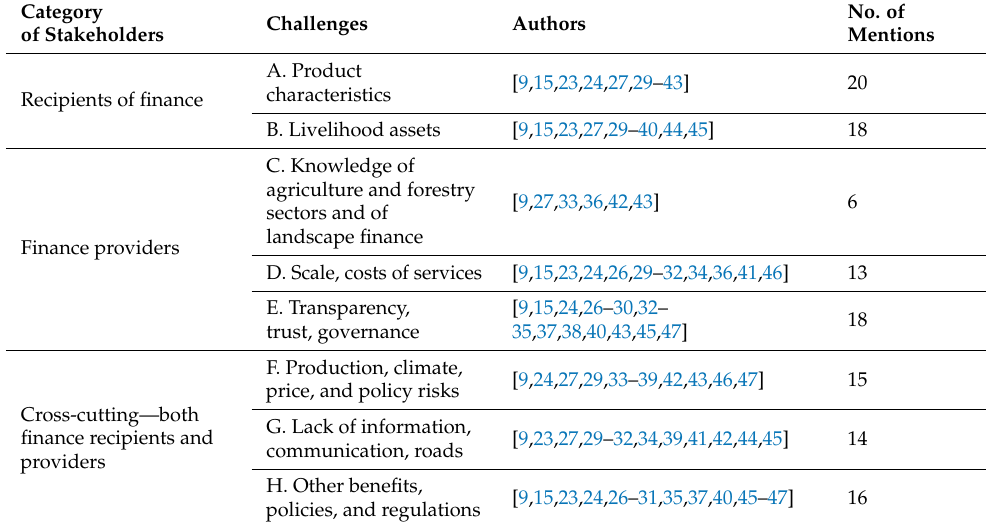
Table 1. Main challenges for landscape finance by category of stakeholders, as identified from the literature